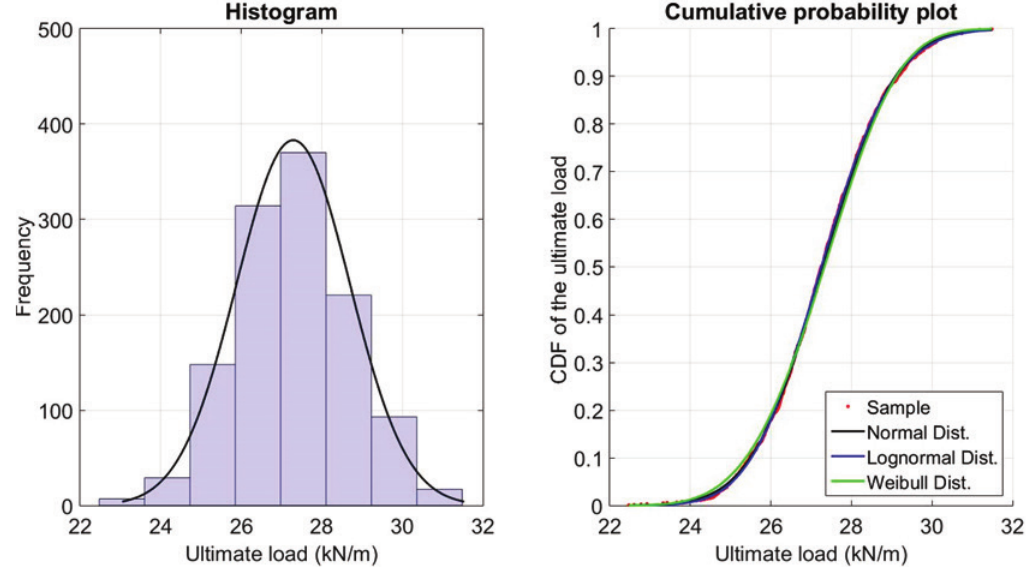
Figure 6.6 Distributions fitness for resistance of the beam V-25-40-r-15 (1200